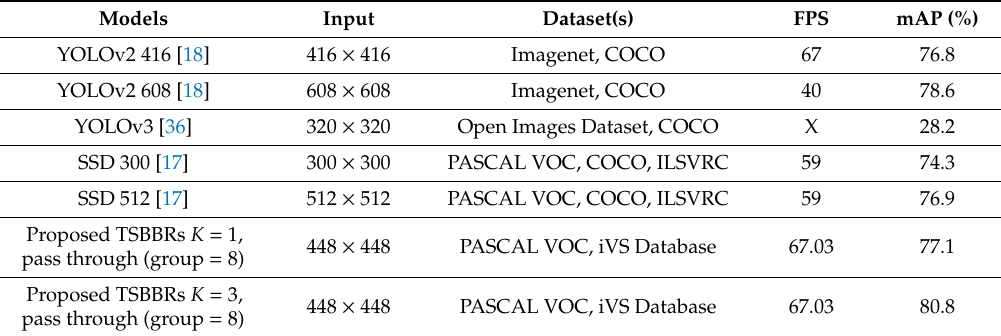
Table 10. Comparison of the proposed method with the state-of-the-art